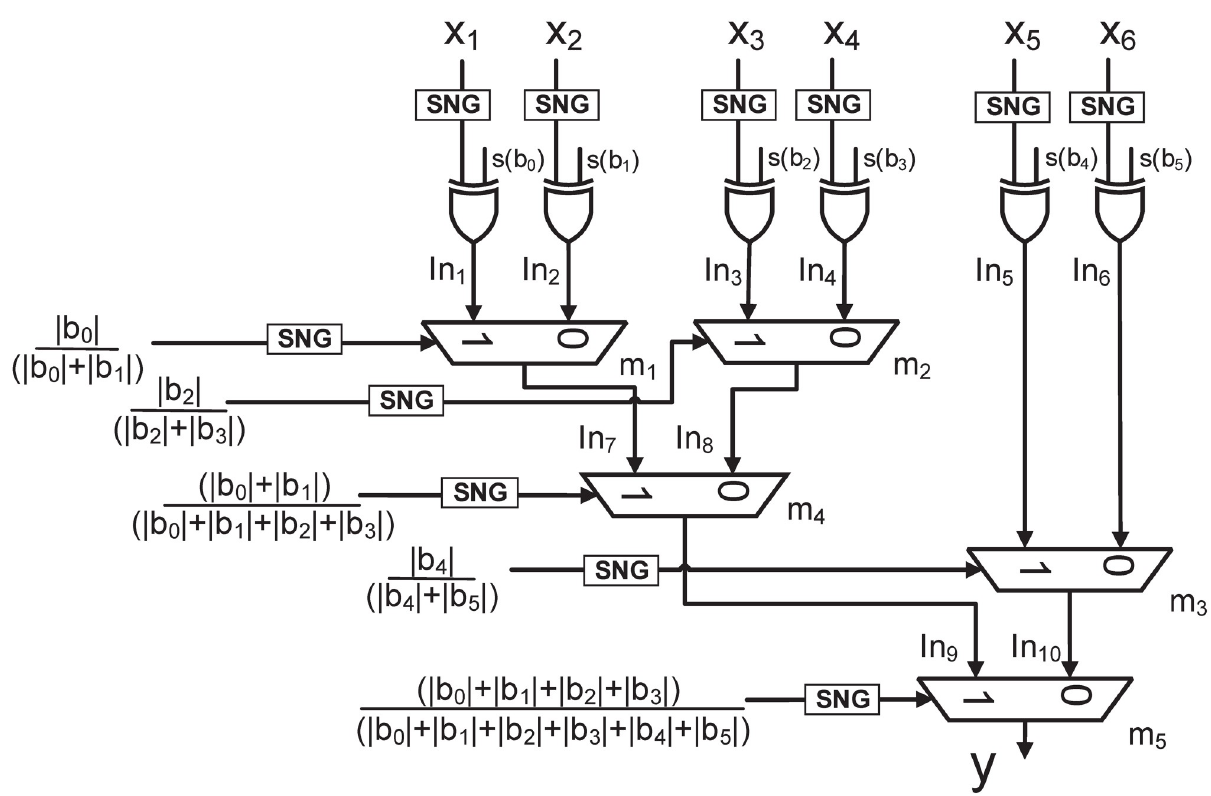
Fig 4. 5 th order SC-based FIR